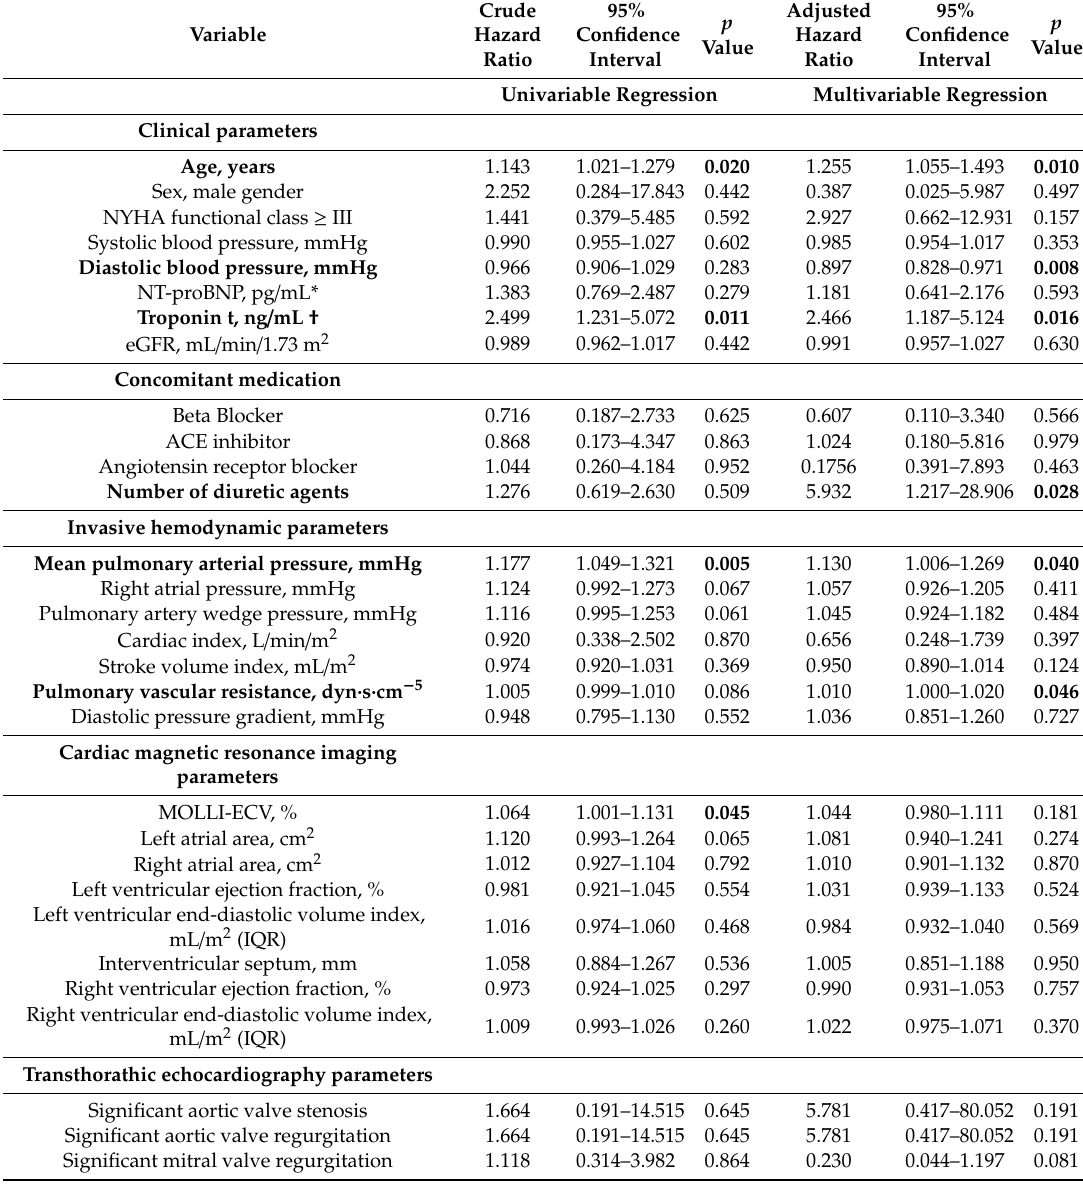
Table 2. Cox regression analysis for the cardiac wild-type transthyretin amyloidosis